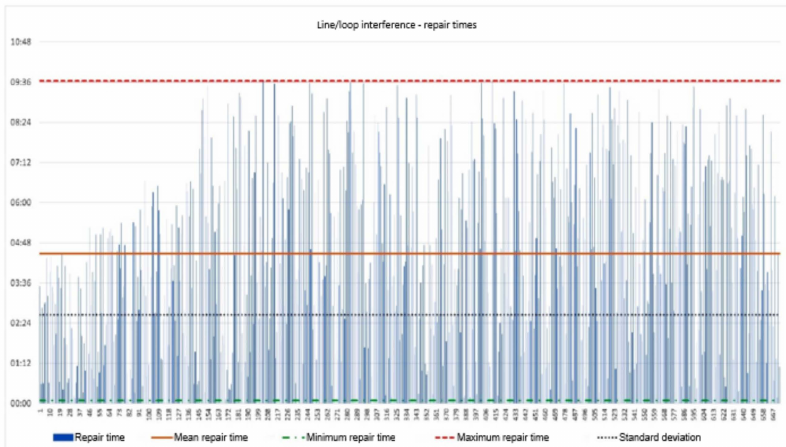
Figure 4. Repair times: line/circuit interference damage. Test results: mean repair time 268 min, minimum repair time 5 min, maximum repair time 578 min, repair time standard deviation 158 min.